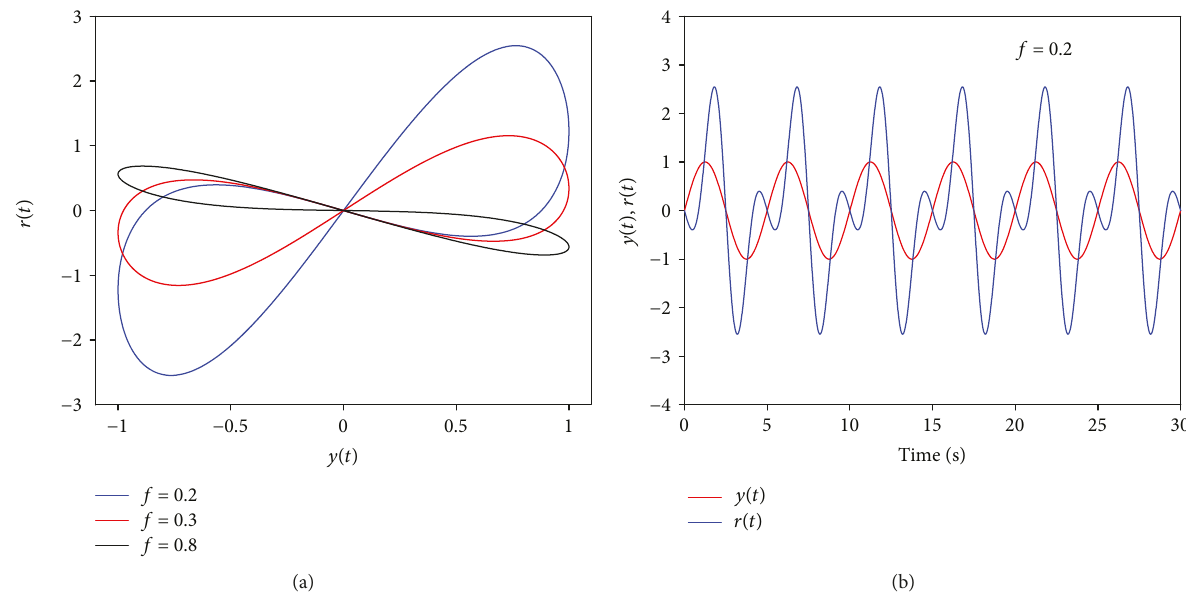
Figure 1: (a) Relationship curves of input and output under di ff erent frequencies and (b) the time-domain waveforms when f = 0 2 Hz